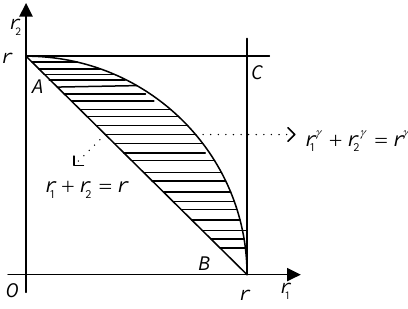
Figure 4. The Energy efficient Dominating Sets (EDS) shown in Equation (3).